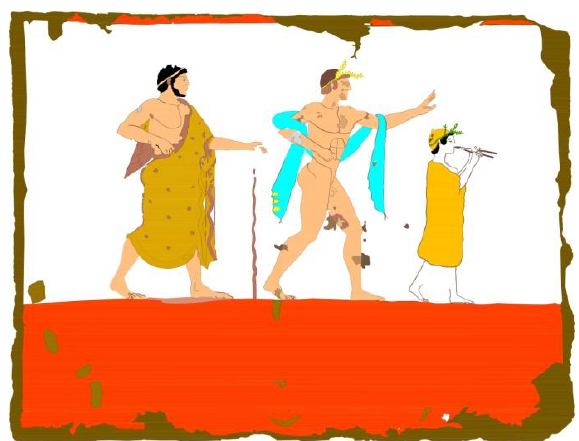
Figure 14. Restitution scene of the procession of Diver’s Tomb